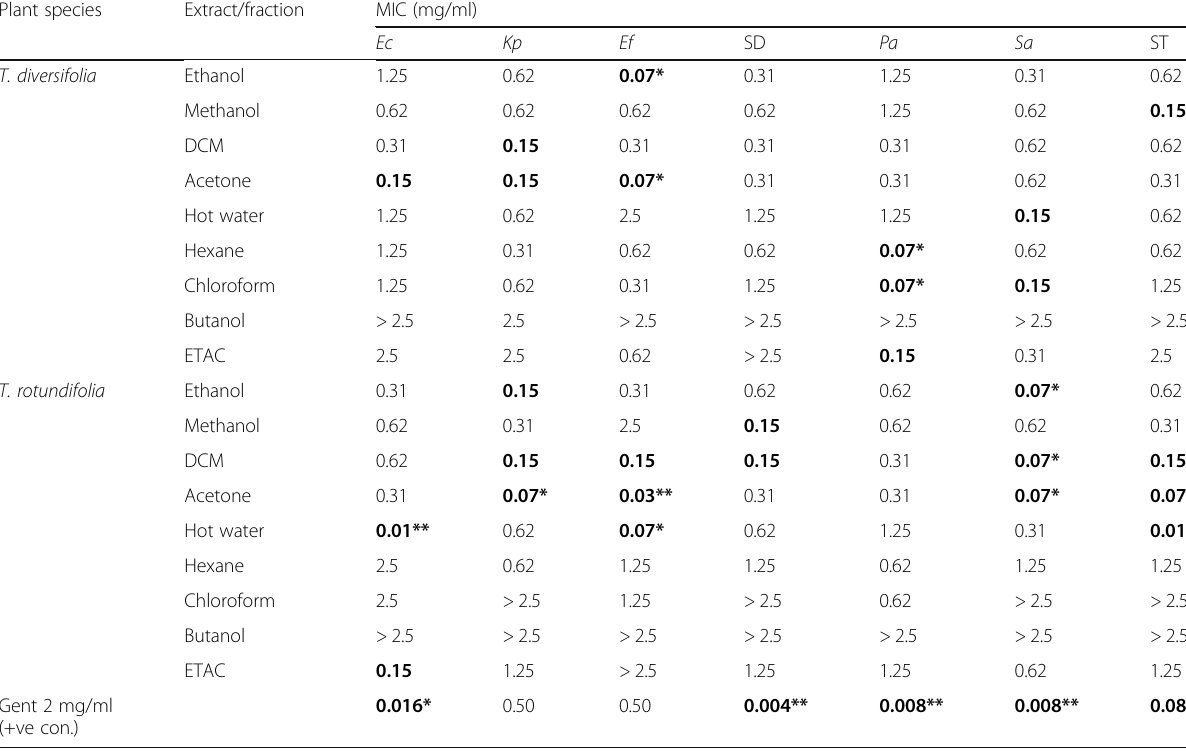
Table 1 Antibacterial activity of solvent extracts and fractions of T. diversifolia and T. rotundifolia Plant species